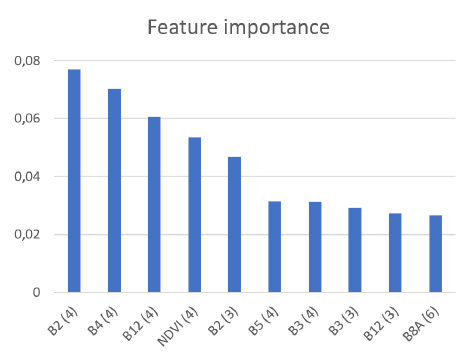
Figure 9. Turkey: Feature importance (top